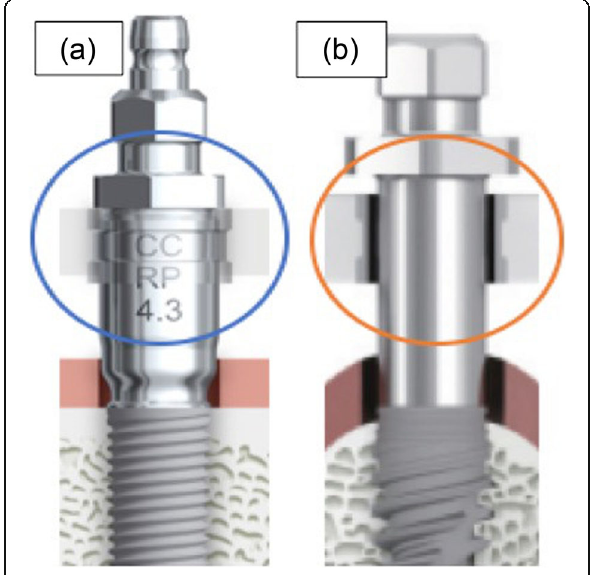
Fig. 4 The types of implants were classified into groups with large and small differences in the diameter between the implant mount and the metal sleeve in the surgical guide. a The smaller gap group contains NobelReplace® CC implants, NobelParallel ™ CC implants, and NobelReplace® Tapered implants. b The larger gap group contains NobelActive ™